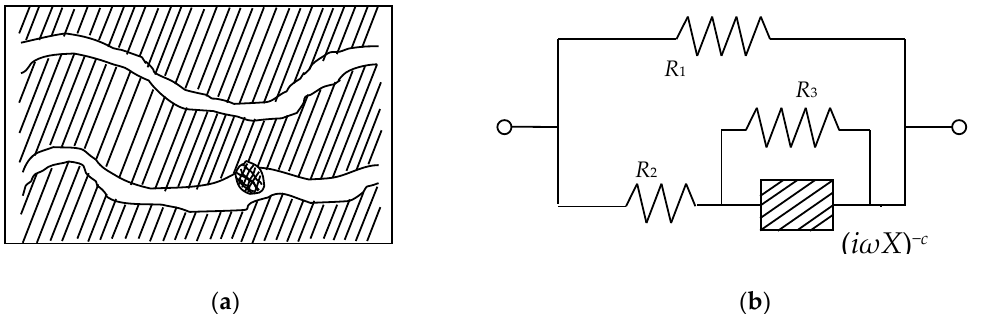
Figure 4. Schematic diagram of the basic structure of mineralized rocks and equivalent circuit. ( a ) Basic structure; ( b ) equivalent circuit.